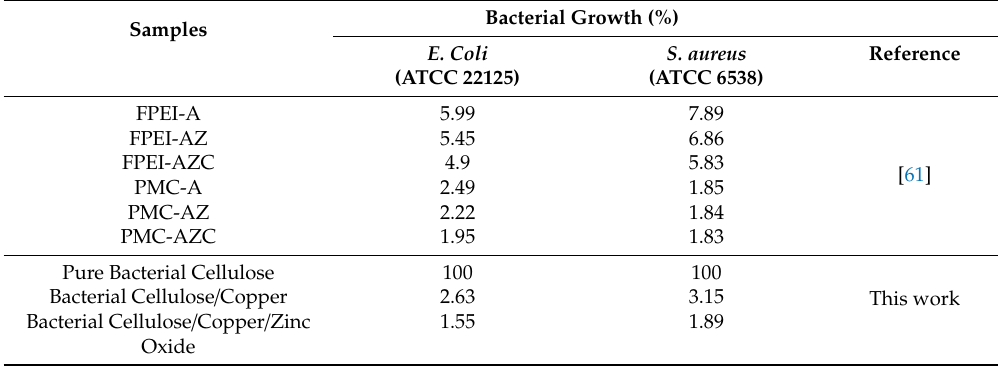
Table 4. Di ff erent nanocomposite materials’ antibacterial characteristics in terms of Escherichia coli and Staphylococcus aureus bacterial